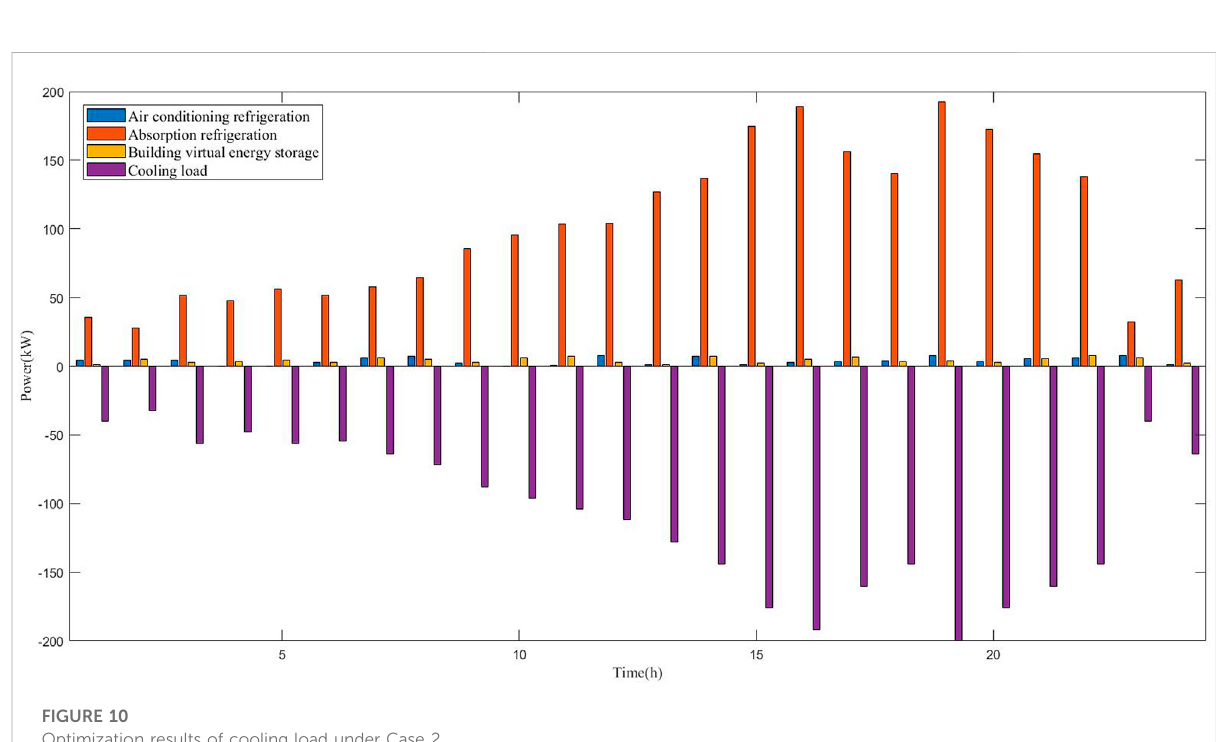
FIGURE 10 Optimization results of cooling load under Case